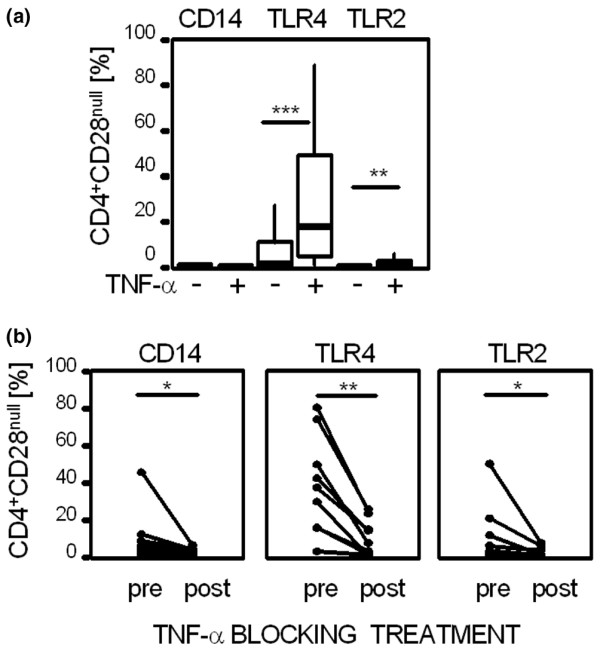
Effects of TNF-α on expression of pattern recognition receptors in vitro and in vivo. (a) Peripheral blood mononuclear cells were stimulated with 20 ng/ml tumour necrosis factor-α (TNF-α) for 24 hours, and CD4+CD28null T cells were analysed for expression of CD14, TLR4 and TLR2. Box plots summarize data from seven independent experiments. Medians were compared using the Wilcoxon test. ***P < 0.001, **P < 0.01. (b) CD4+CD28null T cells in patients with active ankylosing spondylitis treated with infliximab at a dosage of 3 mg/kg body weight were tested for the expression of pattern recognition receptors (PRRs) before and 3 weeks after injection (n = 8). The expression of CD14, TLR4 and TLR2 was detected by flow cytometry. The Wilcoxon test was used to determine differences in expression of PRRs before (pre) and under successful TNF-α blocking treatment (post). **P < 0.01, *P < 0.05.